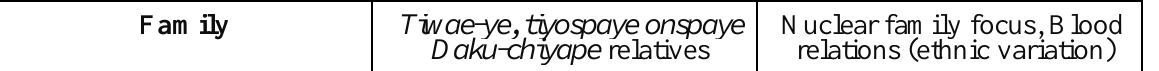
Table 1F. Family Social Sphere